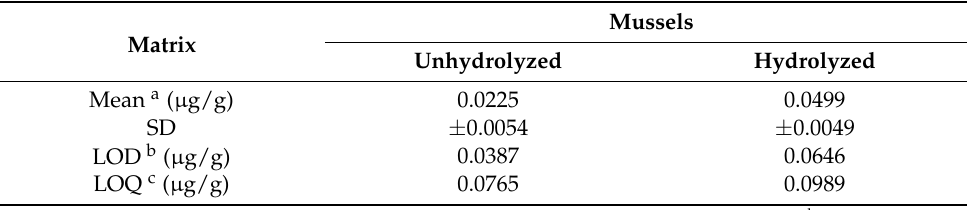
Table 2. Limits of detection (LOD) and quantitation (LOQ) for Mussel.